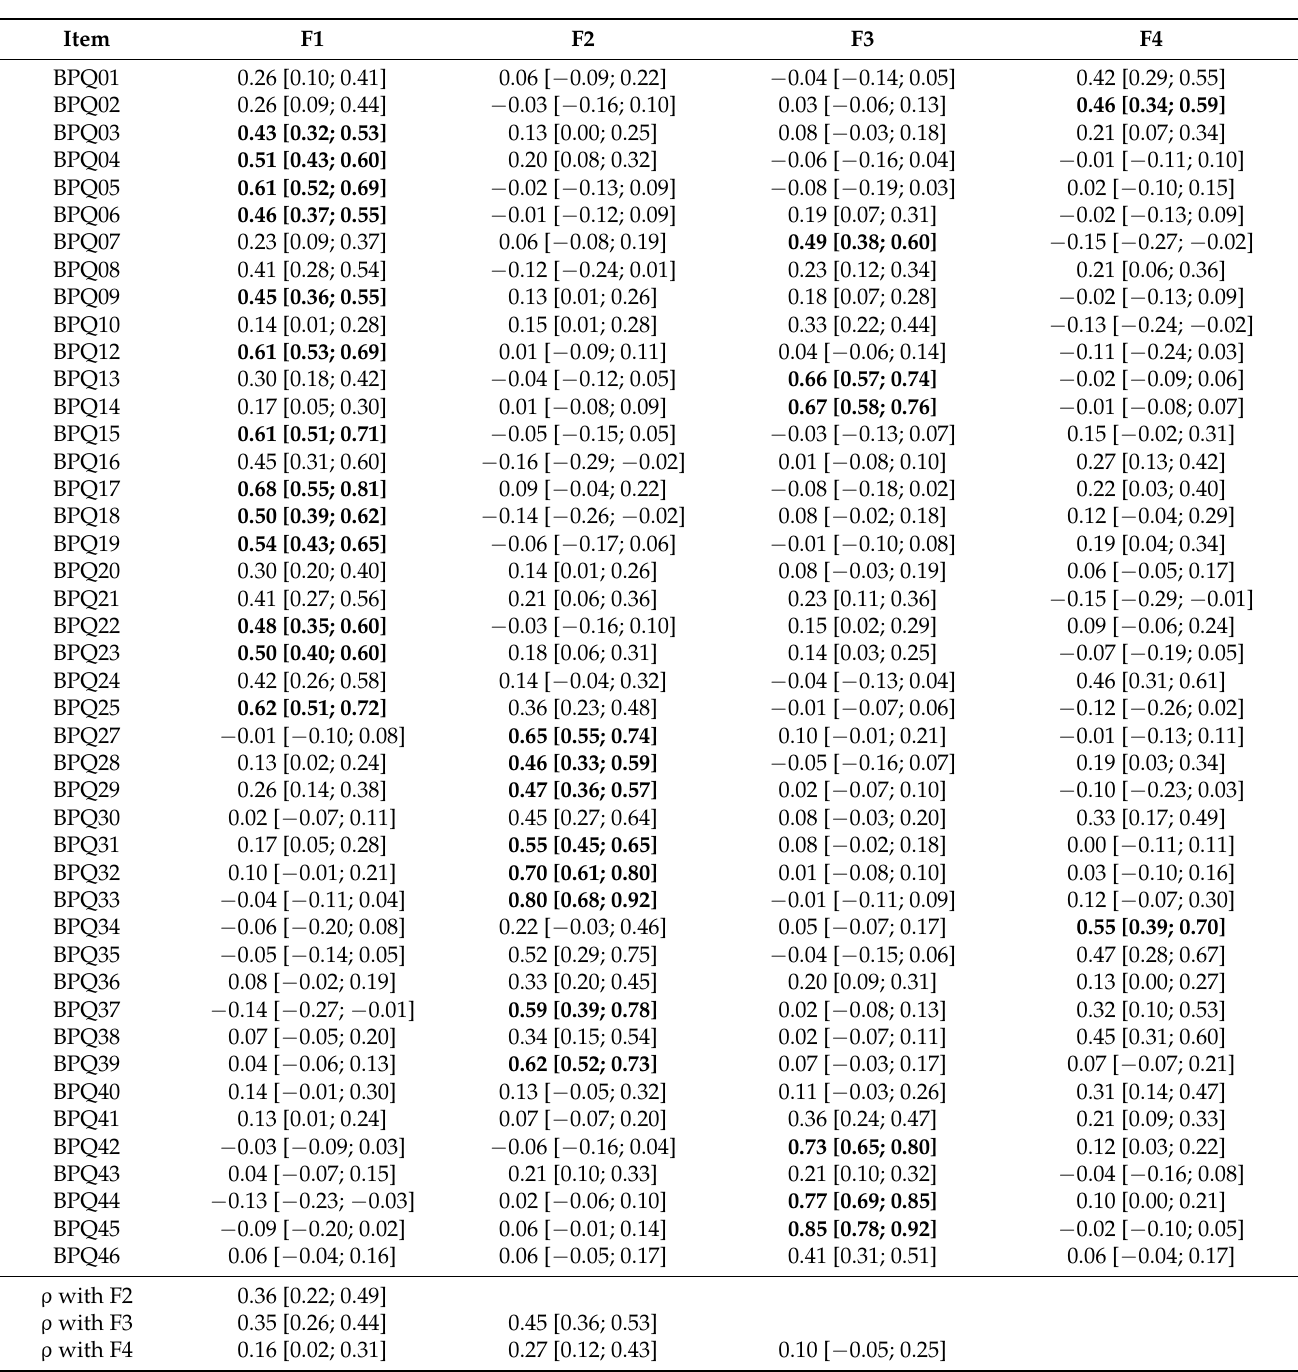
Table 2. Loading matrix and factor correlations of the four-factor exploratory structural equation modeling solution (data from the first random subsample, n =